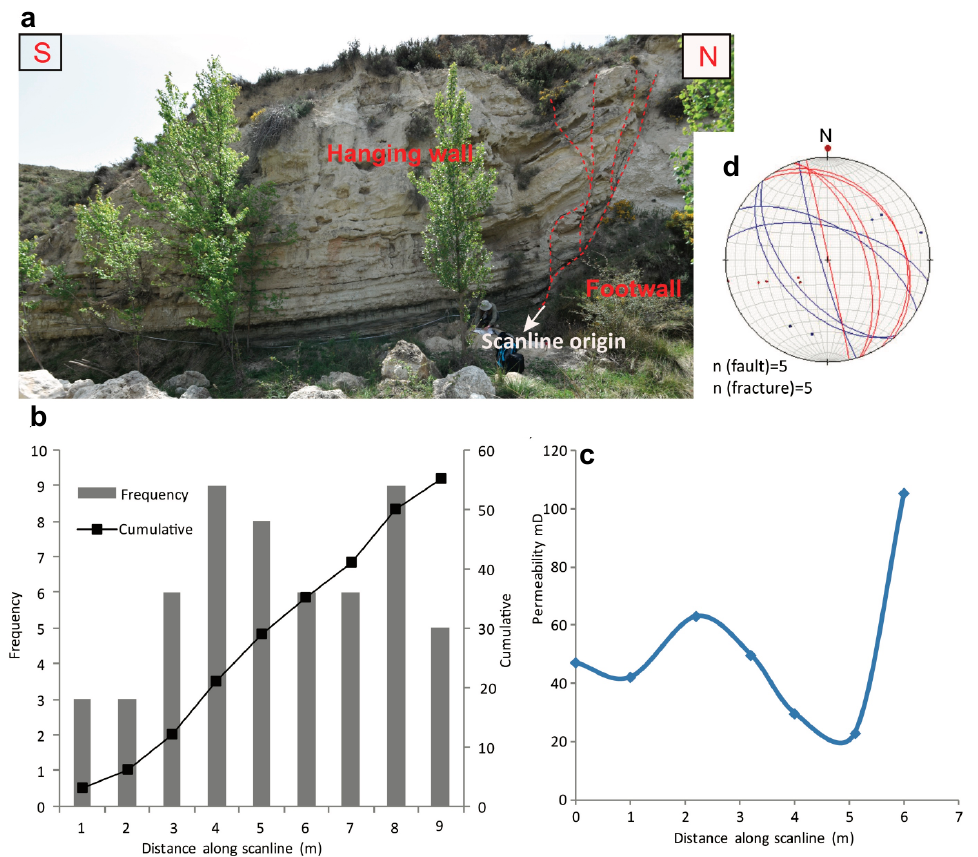
Figure 6. ( a ) Photo of the outcrop exposed in the Carrizal site (central segment of the Baza Fault). The main fault includes clay smear in the fault core and small synthetic faults and fractures in the damage zone. ( b ) Frequency and cumulative distribution of fractures along the scanline. ( c ) Permeability and Young’s modulus measurements along the scanline. ( d ) Stereoplot of the fault (red) and fracture (blue) orientations.